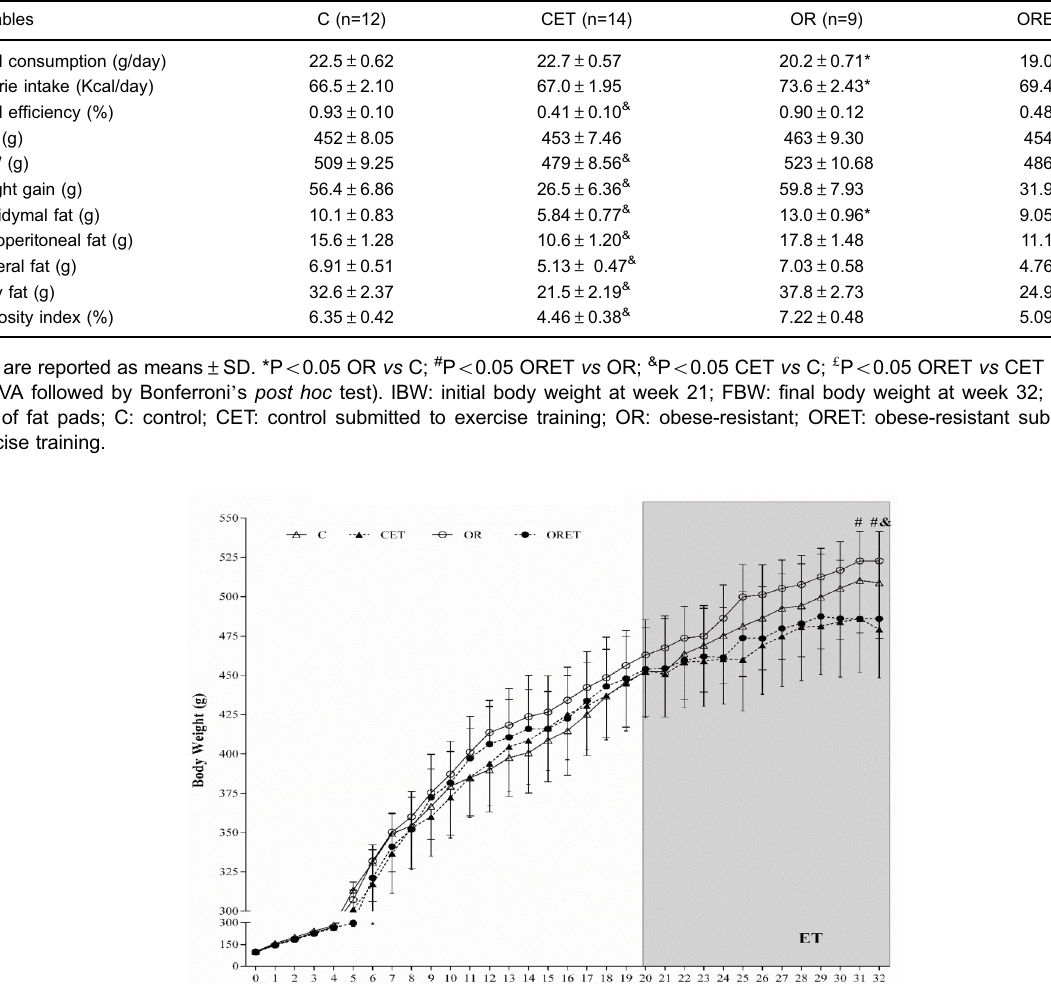
Table 2. Nutritional characteristics after the aerobic exercise training